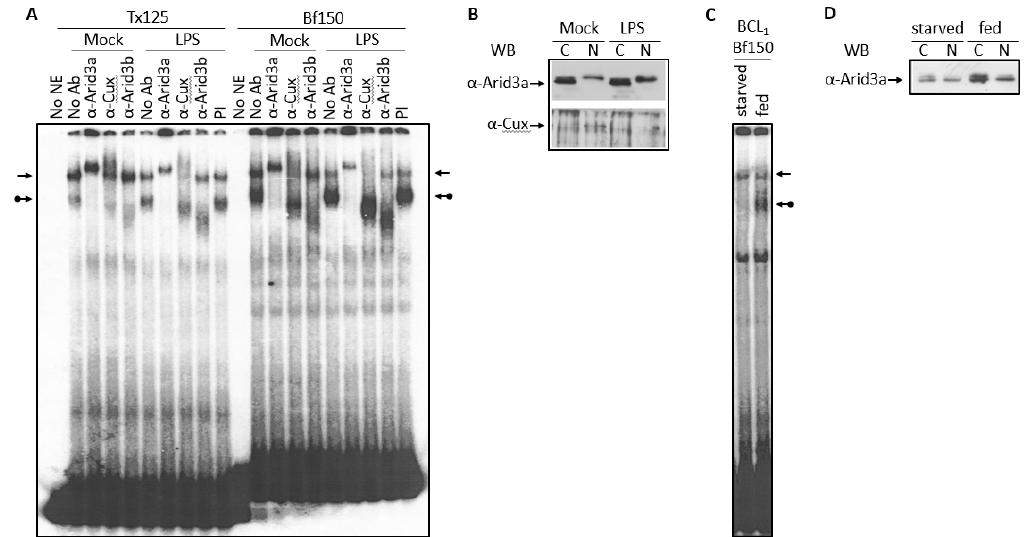
Figure 6. Increased Arid3a expression correlated with the increased Arid3a-DNA interaction. ( A , B ) Nuclei of LPS- or mock-treated BCL 1 cells were extracted. ( A ) The nuclear extract was subjected to EMSA with Bf150 probe and Tx125 probe. The arrows indicate the NF- μ NR complex and the arrows with a ball indicate the Arid3a complex; ( B ) 2 μ g or 5 μ g of extract were separated on SDS-PAGE and Western blotting was performed using anti-Arid3a antiserum or anti-Cux antiserum; ( C , D ) BCL 1 cells were grown with or without fresh media supplement for 3 days. Nuclei were extracted ( C ) The nuclear extract was subjected to EMSA with Bf150 probe; ( D ) 2 μ g of extract was separated on SDS-PAGE and Western blotting was performed with anti-Arid3a antiserum.